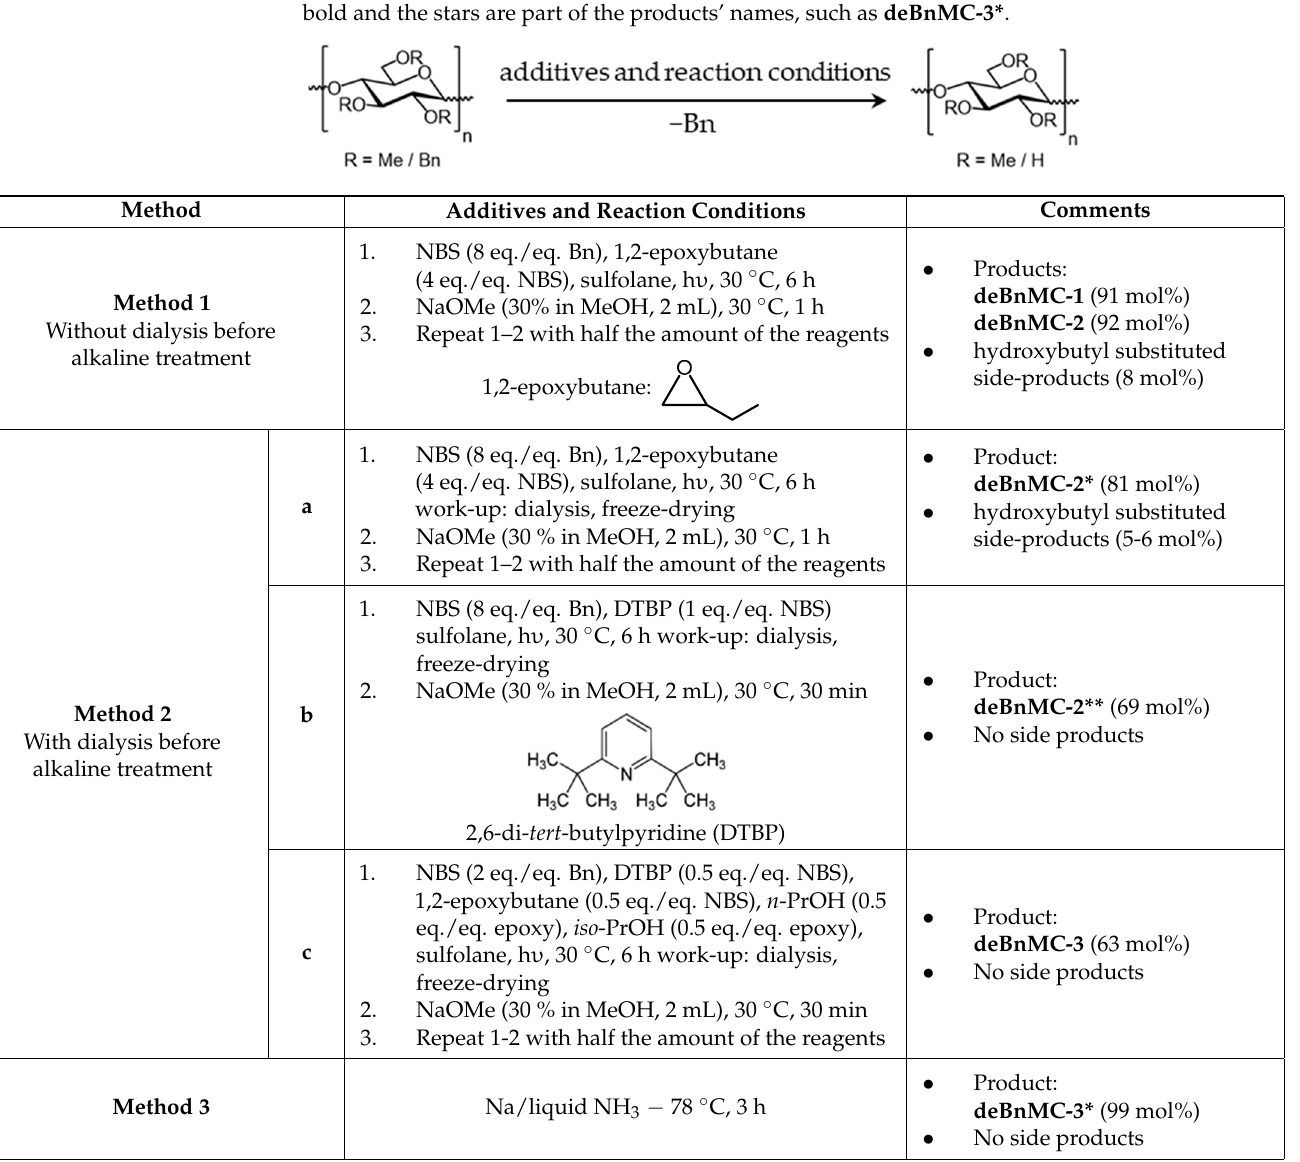
Table 1. Debenzylation Methods, reaction conditions and additives. Products’ names are shown in bold and the stars are part of the products’ names, such as deBnMC-3*